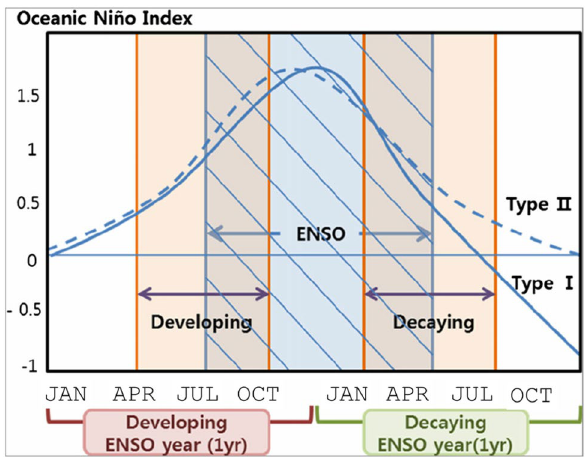
Fig. 4 Schematic diagram of the Oceanic Niño Index for develop- ing El Niño conditions, decaying El Niño conditions, and Type I and Type II years. Type I case of the decaying El Niño is one where El Niño shifts to La Niña. Type II El Niño returns to neutral condition as it decays. Source Modified from Jang and Ha